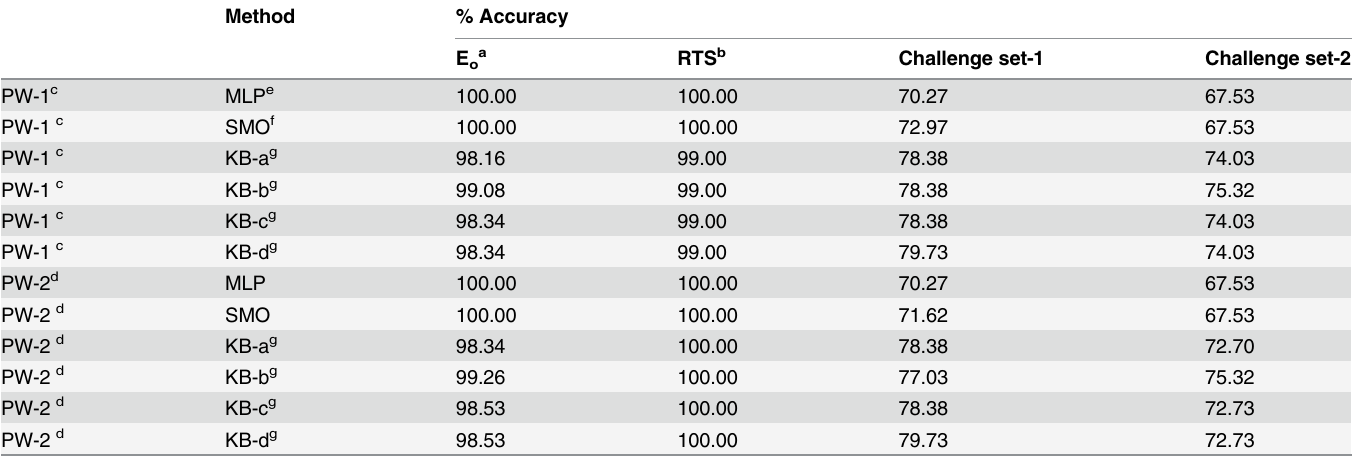
Table 3. Performance of prediction workflows with machine learning methods and knowledge-based